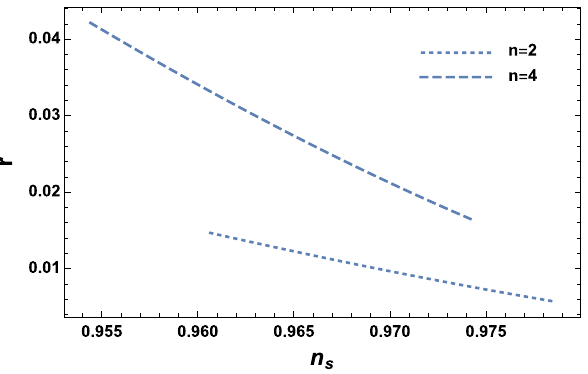
Fig. 18 n s vs r for φ 2 and φ 4 potentials, where the number of e -folds satisfies the consistency with instantaneous reheating (5.18). For n = 2, η wastakenintheinterval0 . 34 ≤ η ≤ 0 . 35and β = 0 . 5,andfor n = 4, 0 . 31 ≤ η ≤ 0 . 33 and β = 0 . 3. Note that both curves satisfy the current observational